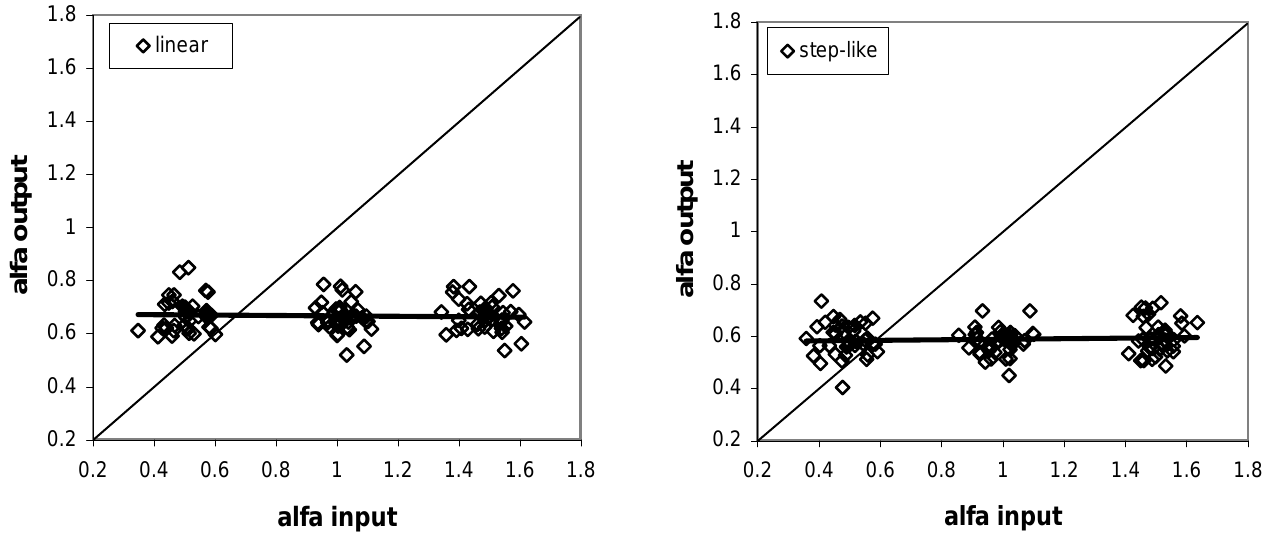
Fig. 7. DFA-calculated vs. expected α exponents for magnitude RSS. All the simulated series were interpolated, resampled by 0.07 day − 1 frequency and their magnitude series were computed. After, DFA was performed to assess the α values.